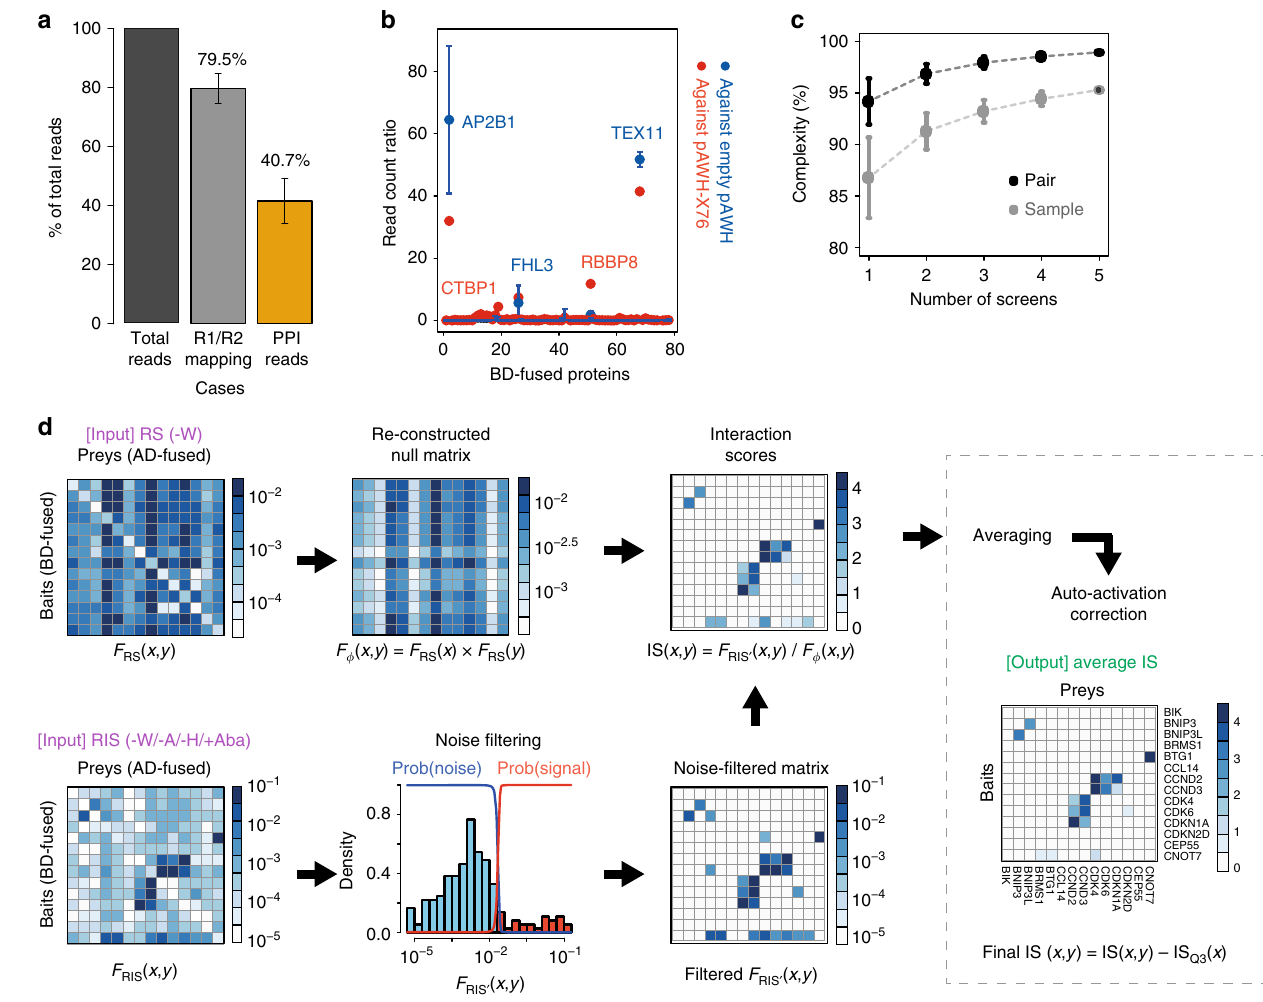
Fig. 2 rec-YnH data analysis. a Estimation of rec-Y2H read mapping ef fi ciency. On average, 79.5% of total reads are mapped with R1/R2 PCR primers (Supplementary Data 2), and 40.7% of reads are usable to map interaction pairs. b A priori detection of auto-activators. As a measure of the auto-activator signal, we calculated the ratio of bait protein-mapped read counts between RIS (recombination – interaction – selection) and RS (recombination – selection) conditions for an AD-empty (pBWH X76 pool/pAWH empty) and a full (pBWH X76 pool/pAWH X76 pool) screen. Blue circles indicate bait signals from the AD-empty screening, while red circles indicate bait signals in the full screen. c Sample and pair complexity as a function of the number of X71 library screens (X71 = the X76 library without auto-activators or toxic proteins; see Supplementary Fig. 8). Sample complexity is the fraction of pairs that form out of all possibilities under RS conditions, while pair complexity is the fraction of ORF combinations irrespective of the domain (i.e., BD or AD) to which they were fused. d Computational analysis pipeline of rec-YnH. The reconstructed null matrix is generated by normalising to total read counts and then to the frequency of bait – prey pairs under RS conditions ( F RS ( x , y )). F RS ( x ) and F RS ( y ) indicate the row-wise and column-wise sum of the detection frequency F RS ( x , y ), respectively. Gaussian mixture fi tting is used to fi lter out noise from the protein interaction signal of the RIS matrix ( F x , y )). The noise- fi ltered signal RIS ( ( F RIS ′ ( x , y )) is further normalised by the null matrix ( F ϕ ( x , y )) to generate the interaction score (IS) matrix. This corrects for clone overrepresentation. To remove stochastic false positives and increase sensitivity, several experiments are averaged, and a fi nal averaged IS matrix is generated. Finally, basal auto- activation levels are removed by the subtraction of the upper quartile interaction score (IS Q3 ( x ) = row-wise top 25 percentile IS) for each bait protein. Usually IS Q3 ( x ) is 0 for non-auto-activator proteins. The same pipeline was applied to all rec-YnH screens done here. a – c Error bars represent